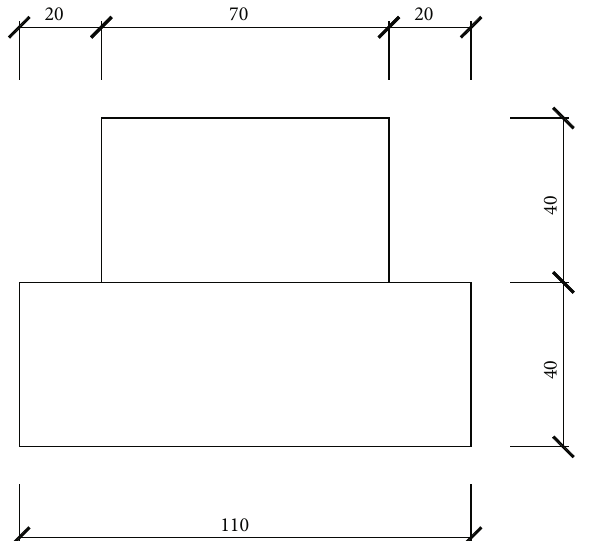
Figure 11: Generalized model of the structural plane under a cyclic shear load (units = mm).